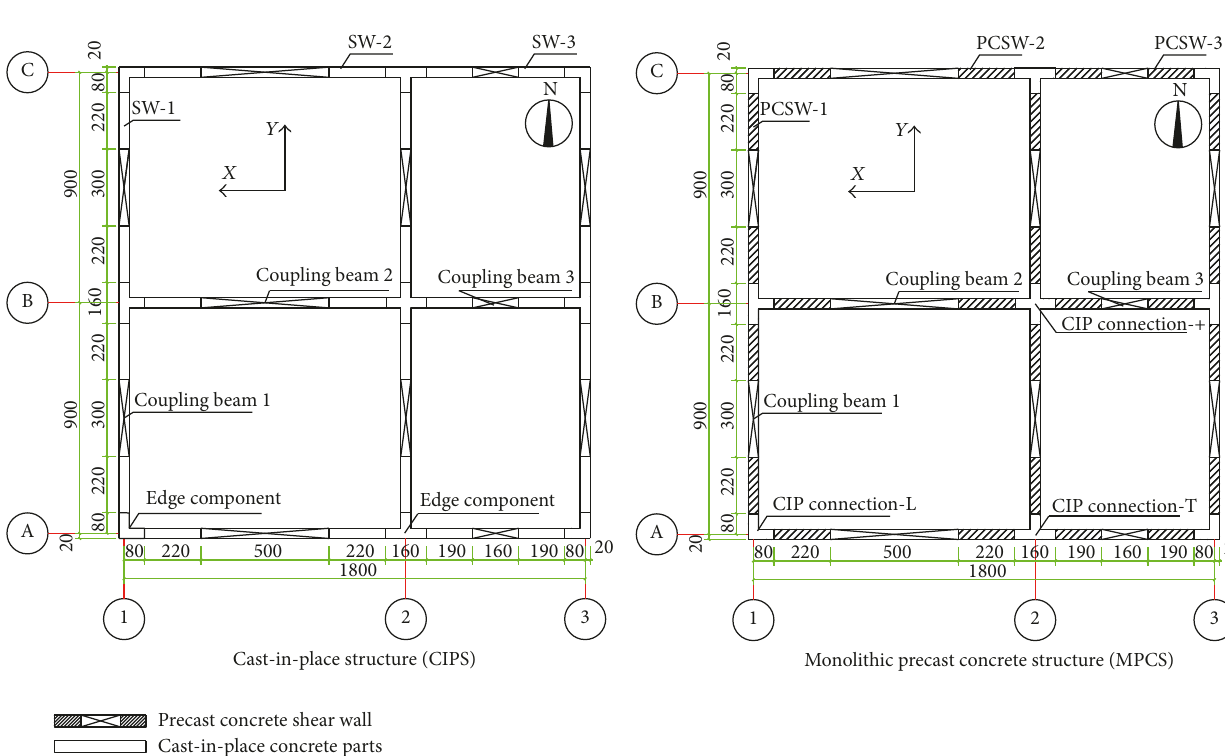
Figure 1: Plane view of CIPS and